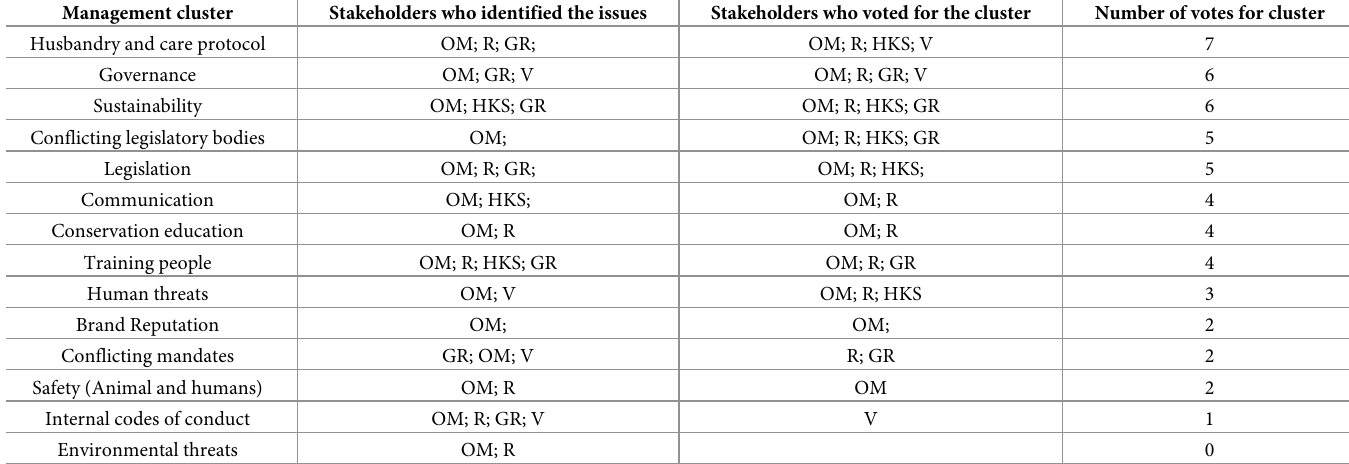
Table 2. Management clusters and votes (OM = Owners and Manager; R = Researchers; HKS = Handlers/Keepers/Staff; GR = government Representatives; V = veterinarians). Full details in S5 Table.